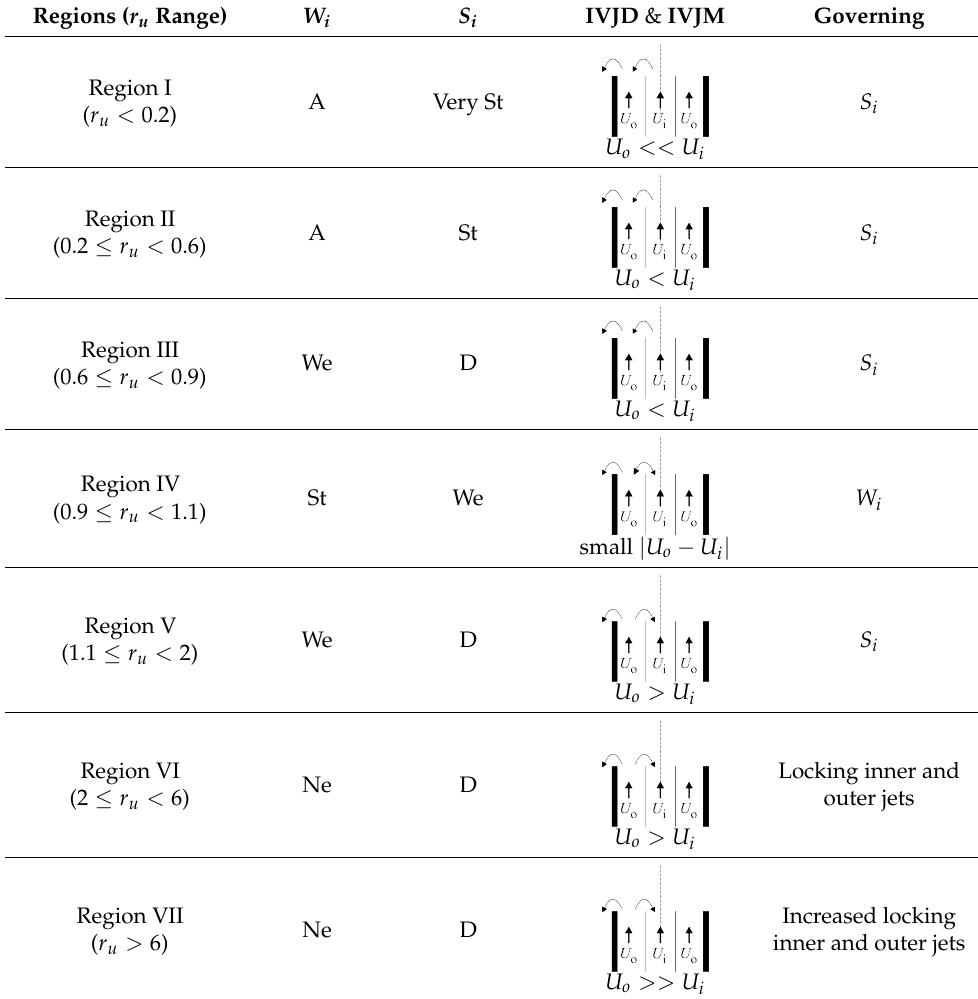
Table 2. Inner mixing layer characteristics for various ranges of velocity ratios. Wake and shear instabilities are denoted by “ W i ” and “ S i ”, respectively. The following abbreviations are used: “IVJD” and “IVJM” denote inner mixing layer’s velocity jump direction (curved arrows) and magnitude, respectively; “A” (Absent), “St” (Strong), “D” (Dominant), “We” (Weak), “Ne” (Negligible). Regions ( r u Range) W i S i IVJD & IVJM Governing Region I S i A Very St ( r u < 0.2) U o << U i Region II St r u < 0.6) (0.2 ≤